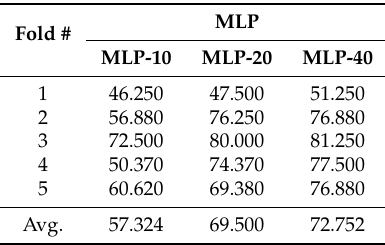
Table 4. Testing set accuracy (%) of each MLP over 5-fold cross-validation. Fold